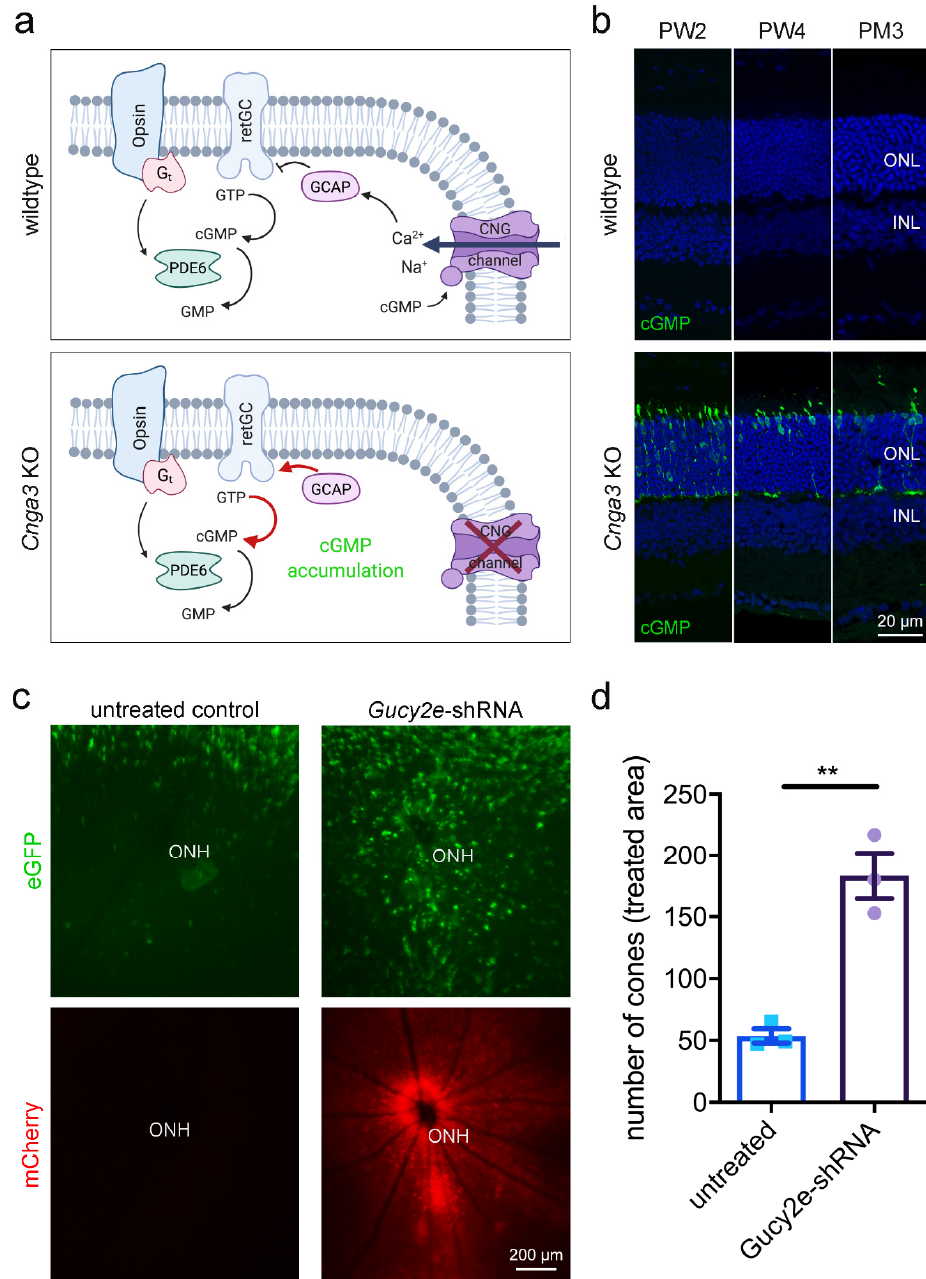
Figure 1. Accumulation of cyclic guanosine monophosphate (cGMP) in cone photoreceptors of Cnga3 KO mice. ( a ) Cartoons illustrating key components of the visual signalling cascade in wildtype (upper part) and Cnga3 KO (lower part) cone outer segments (see text for details). The cartoon was created with BioRender.com. ( b ) Confocal scans from wildtype (upper panels) and Cnga3 KO (lower panels) retinal cross-sections immunolabelled for cGMP (green) to illustrate the exuberant levels of cGMP in affected cones. Due to the relatively low affinity, the anti-cGMP antibody fails to detect any signal in the wildtype retina. The scale bar applies to all images. ( c , d ) Subretinal administration of adeno-associated virus (AAV) vectors encoding a shRNA directed against Gucy2e preserves the number of cones in RG-eGFP/ Cnga3 KO mice. In addition to the Cnga3 deletion, the mouse line carries a transgene for cone-specific expression of eGFP. The delivered AAV vector also mediates mCherry expression, which allows for visualisation of the virally transduced area in the fundus imaging ( c ). The contralateral non-injected eye served as control. The scale bar applies to all images. ( d ) Quantification of the number of eGFP-positive cones from fundus fluorescence images revealed a significant preservation upon AAV- Gucy2e -shRNA treatment at 3 months after injection ( n = 3, ** p < 0.01, Student’s t -test). Error bars shown are SEM. INL, inner nuclear layer; ONH, optic nerve head; ONL, outer nuclear layer; PW, postnatal